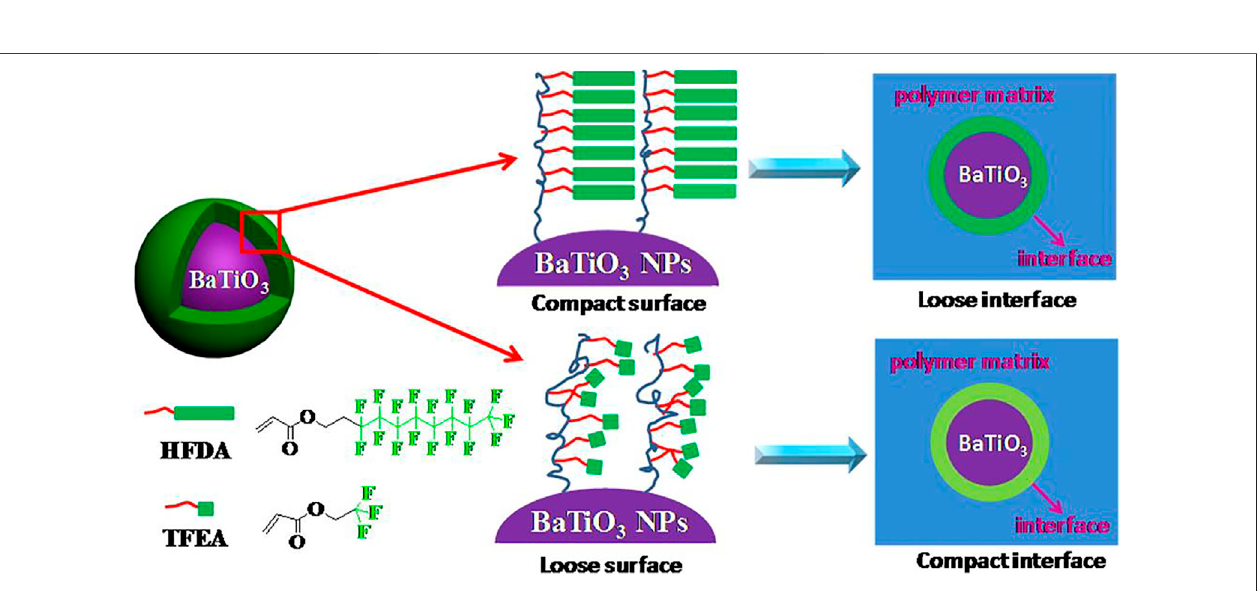
Frontiers in Materials |